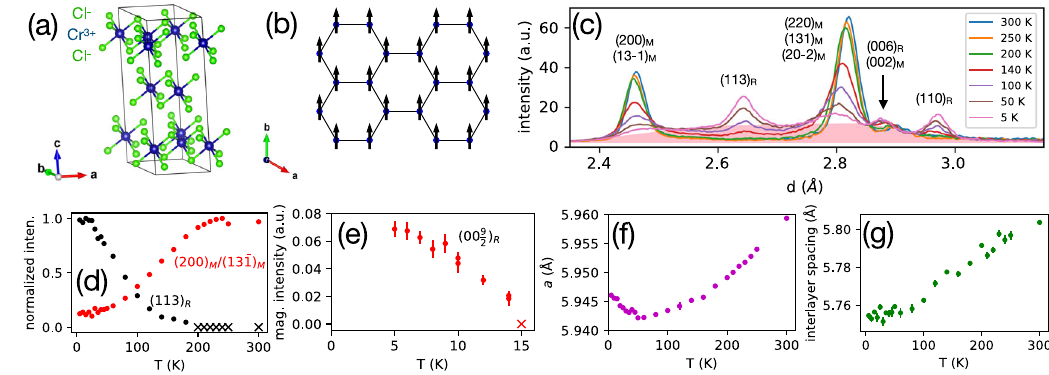
Fig. 1 Structural details. a The crystal structure diagram of the R 3 -phase in CrCl 3 . b A honeycomb layer in CrCl 3 with spins illustrated. c Powder diffraction data (intensity vs. lattice spacing d ) collected on cooling from 300 to 5 K with Bragg peaks belonging to the two phases, labeled M-monoclinic and R-rhombohedral. The shaded region shows the diffuse scattering part of the intensity at 5 K. d Integrated intensity (cid:1) (cid:3) = 131 and 200 ð Þ peaks plotted as a function of temperature, showing the progression of the transition on cooling from 300 K. of the 113 ð Þ (cid:1) (cid:3) R M M peak, present below 15 K. Data collected on both cooling and Error bars smaller than symbols. e Integrated intensity of the magnetic 00 9 2 R warming. f Temperature-dependence of the a -axis lattice constant. A feature resembling negative thermal expansion is observed below ~50 K. = 006 ð Þ g Interlayer spacing obtained from the position of the 002 ð Þ Bragg peak. Data in ( f ) and ( g ) collected on cooling. Error bars represent M R one standard